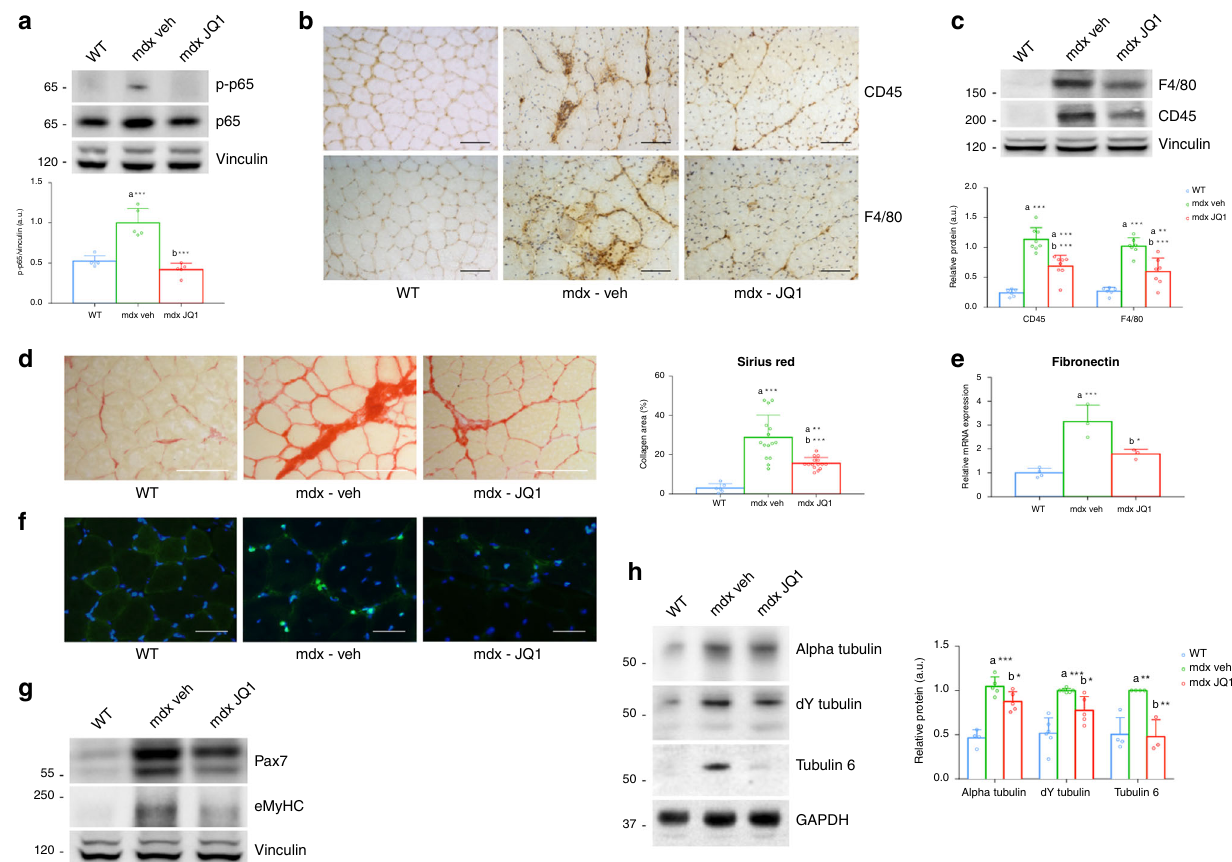
Fig. 6 JQ1 treatment ameliorates pathological phenotypes in dystrophic muscle. a JQ1 administration decreases NFkB p65-Ser536 phosphorylation in TA muscles from mdx mice ( n = 5 for each experimental group). Lower panel: quanti fi cation of signals was performed with ImageJ. Data are expressed as the mean ± SD. *** P < 0.001. Statistical signi fi cance was determined by using one-way ANOVA followed by Tukey ’ s post hoc test. b Immunohistochemical evaluation of F4/80 and CD45 ( n = 3 for each experimental group). Scale bar: 50 µ m. c Immunoblot analysis of F4/80 (WT, n = 6; mdx, n = 7; mdx + JQ1, n = 7) and CD45 (WT, n = 6; mdx, n = 8; mdx + JQ1, n = 8) in muscles from control, vehicle- and mdx-treated mice. Vinculin serves as a loading control. Lower panel: quanti fi cation of signals was performed with ImageJ. Data are expressed as the mean ± SD. ** P < 0.01, *** P < 0.001. Statistical signi fi cance was determined by using one-way ANOVA followed by Tukey ’ s post hoc test. d Sirius red staining shows attenuation of fi brosis in JQ1-treated mice ( n = 2 sections examined from n = 3 WT animals; mdx mice, n = 5 sections examined from n = 3 mdx-veh and mdx-JQ1 animals). Scale bar: 50 µ m. Right panel: